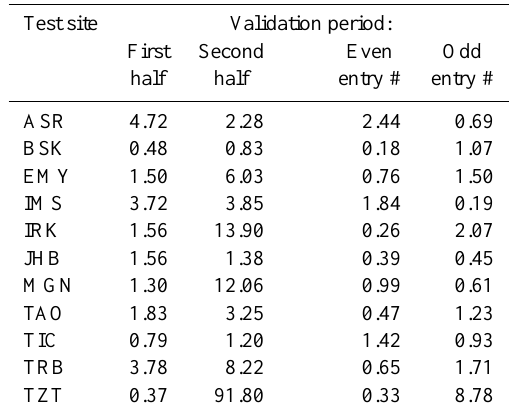
Table 3. Validation of combined approach with the quantile skill score (QSS, see Appendix